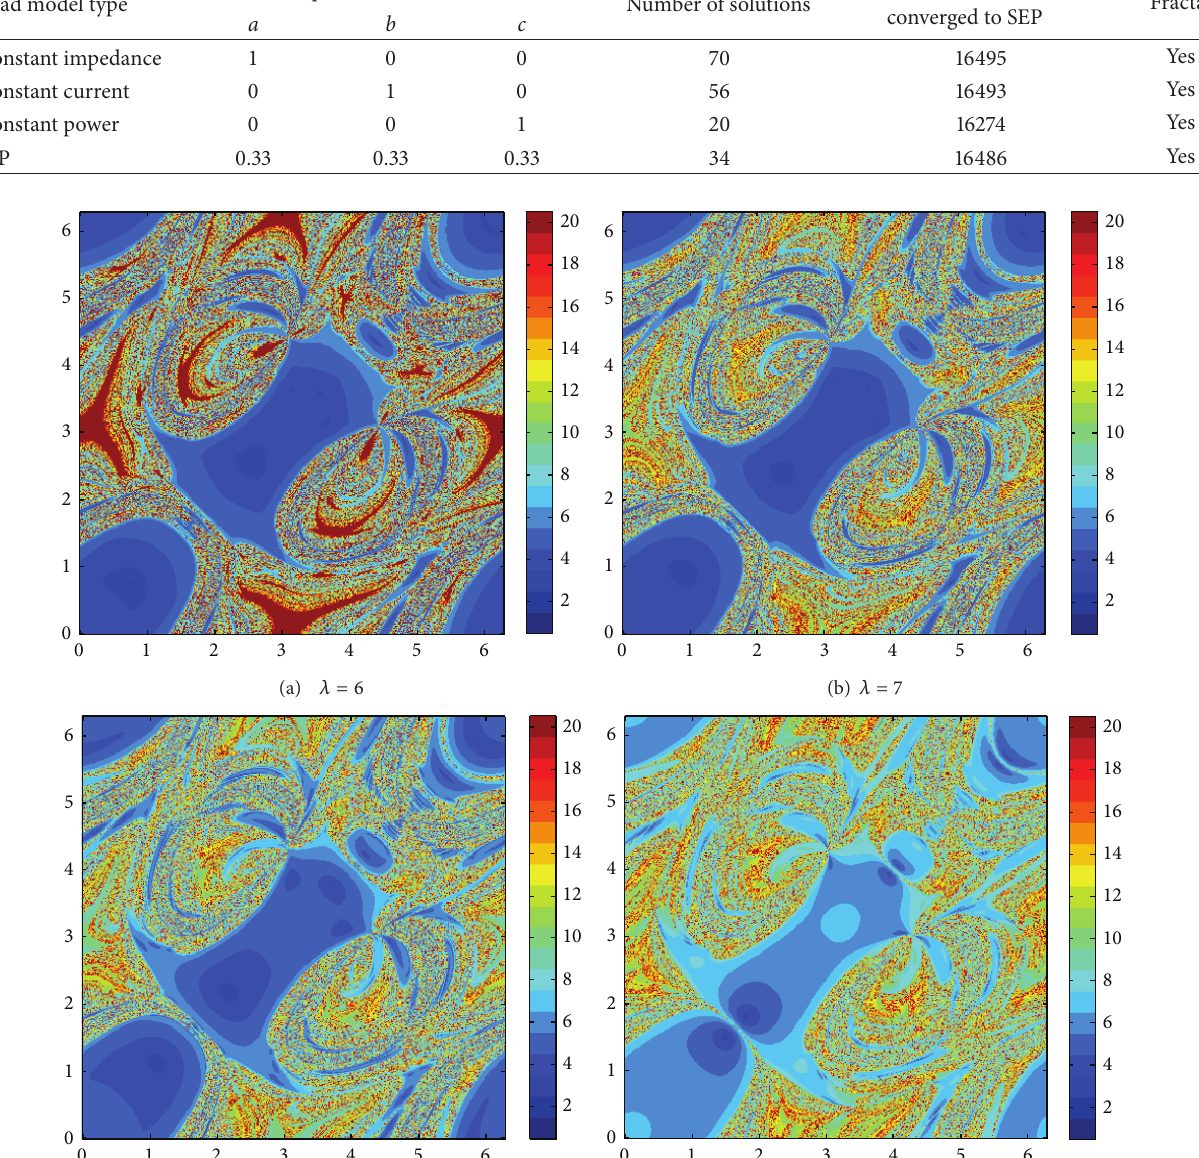
Table 5: Load parameters, the size of convergence region, number of power flow solutions, and fractal property for different load models. Load model type